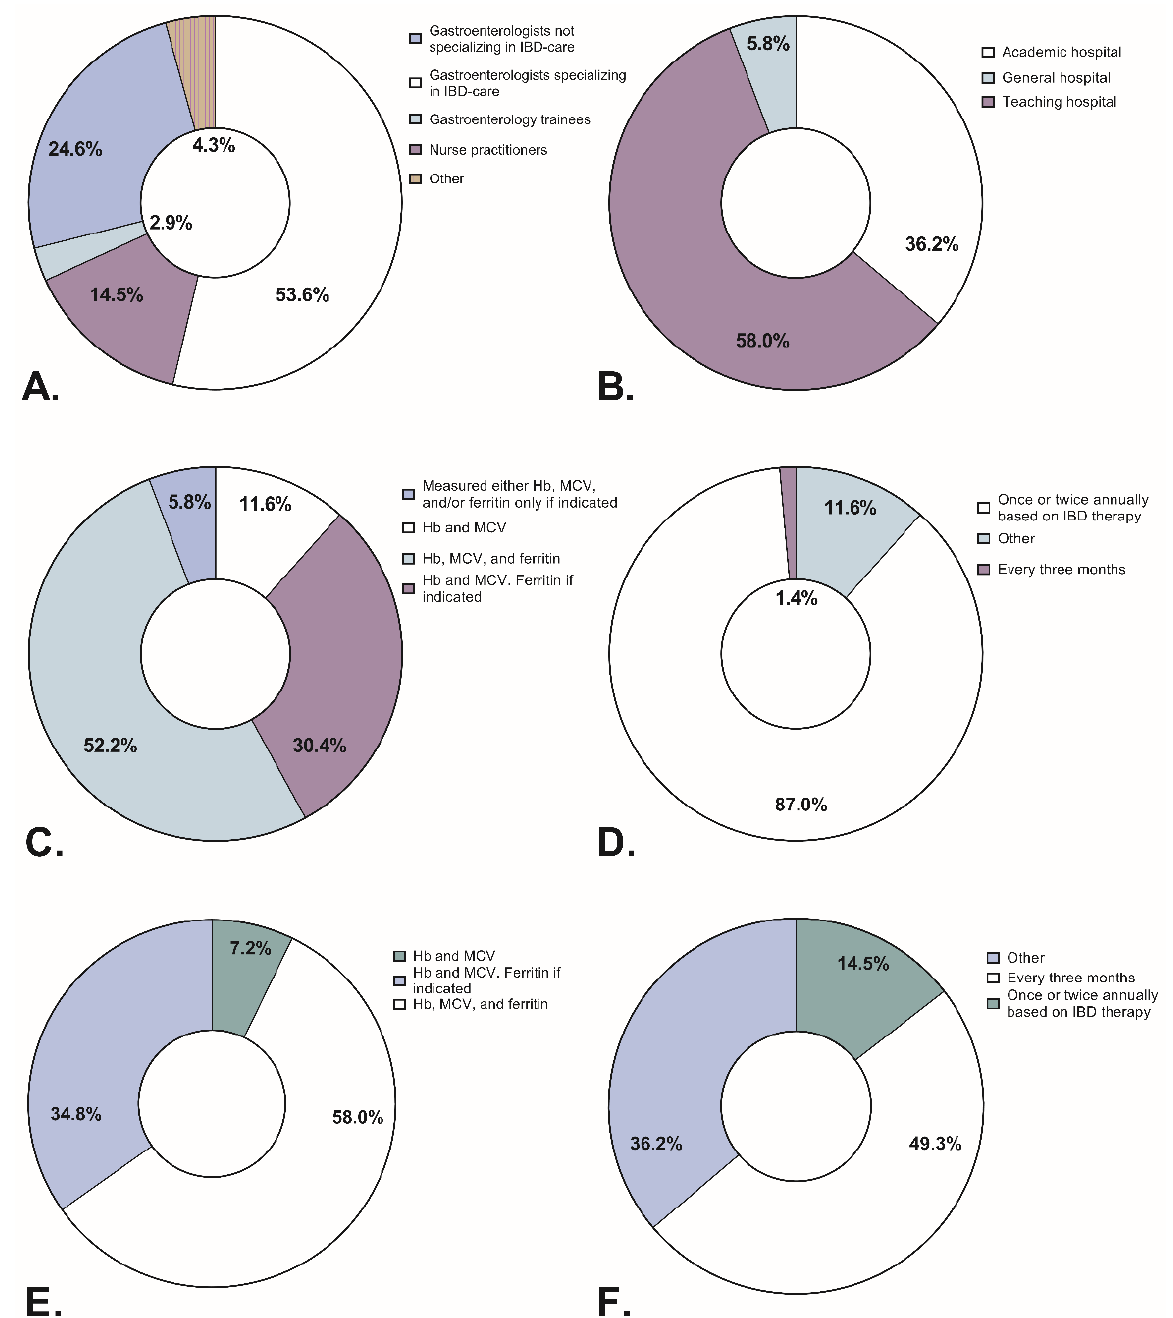
Figure 2. Respondent data regarding profession, place of employment, and screening for anemia and iron deficiency in patients with Inflammatory Bowel Disease. ( A ) Percentages indicating respondents’ profession. ( B ) Percentages indicating respondents’ place of employment. ( C ) Percentage of respondents and the parameters used to screen for anemia and iron deficiency in patients with quiescent Inflammatory Bowel Disease. ( D ) Percentage of respondents and the